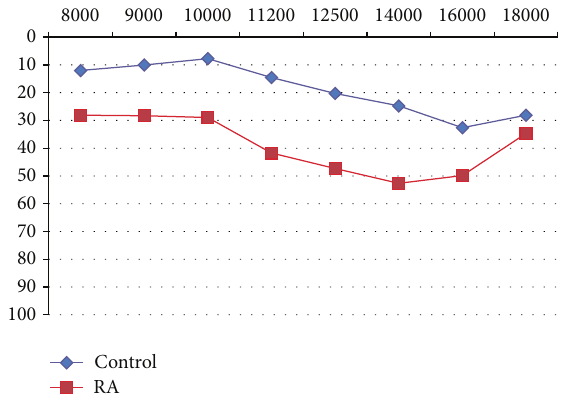
Figure 2: Hearing threshold with ultra high-frequency audiometry, without an age range, in both the control population and the study population with RA. Arithmetic means ( 𝑦 -axis: intensity, dB; 𝑥 -axis: frequency, Hertz or Hz). RA: rheumatoid